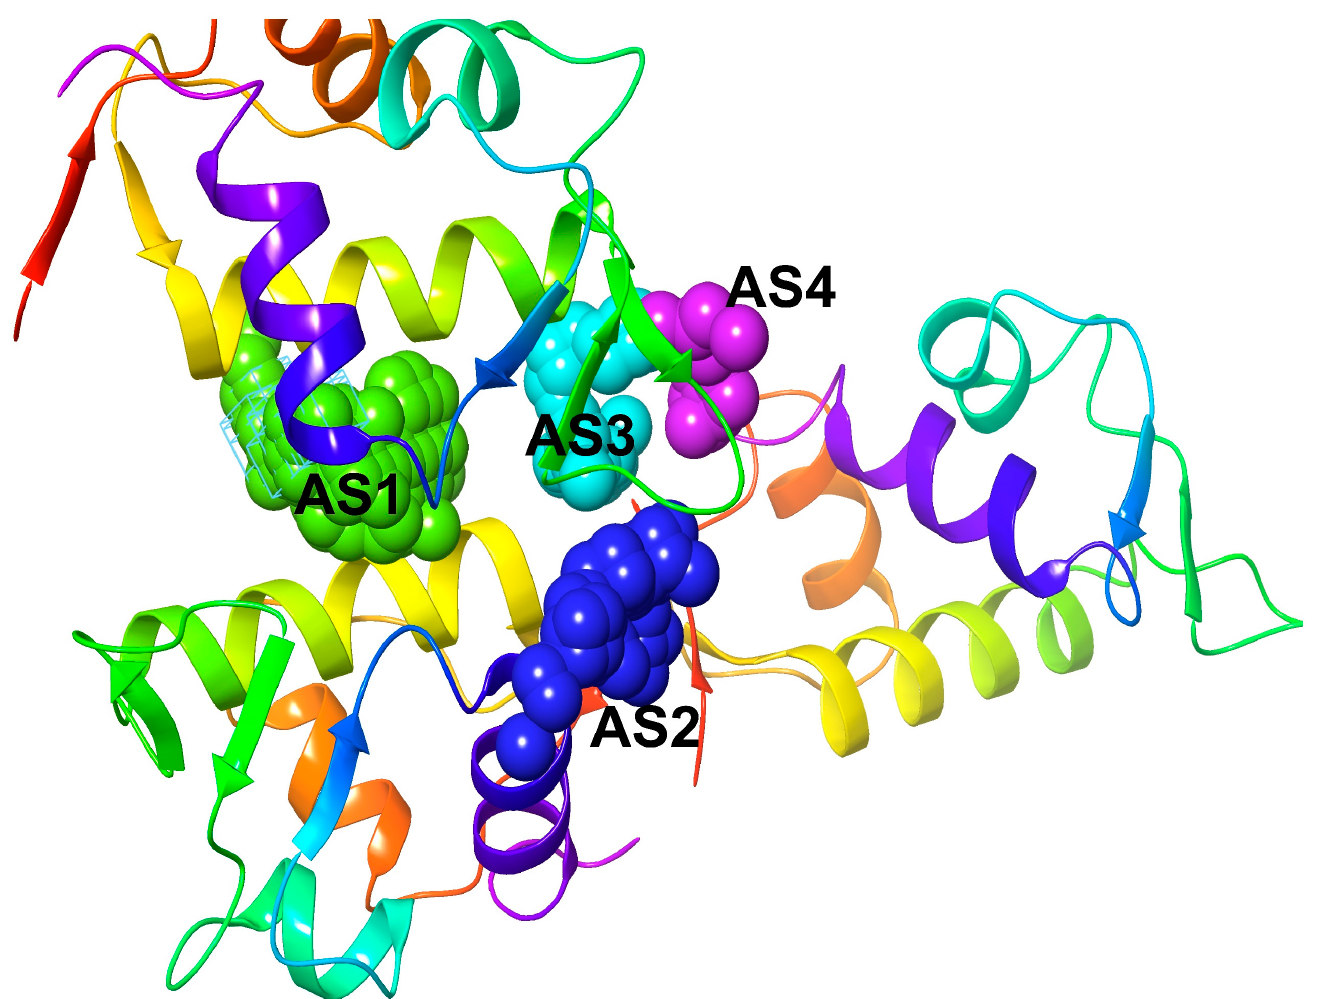
Figure 9. Representing the predictive active site (AS) of MDM2 protein retrieved from Site Map application of Maestro package, Schrödinger Software, where the ball and sticky shape with different colors possessed these predictive active sites with the receptor atom (signified by the interactive amino acid residue numbers of the MDM2 protein).